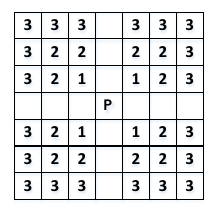
Figure 5. The representation of the array of cells in HoG [28].